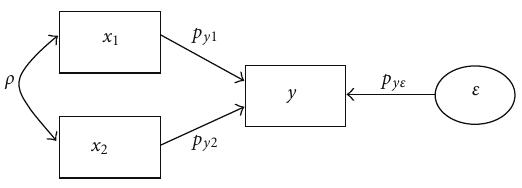
Figure 1: Path diagram of a structural